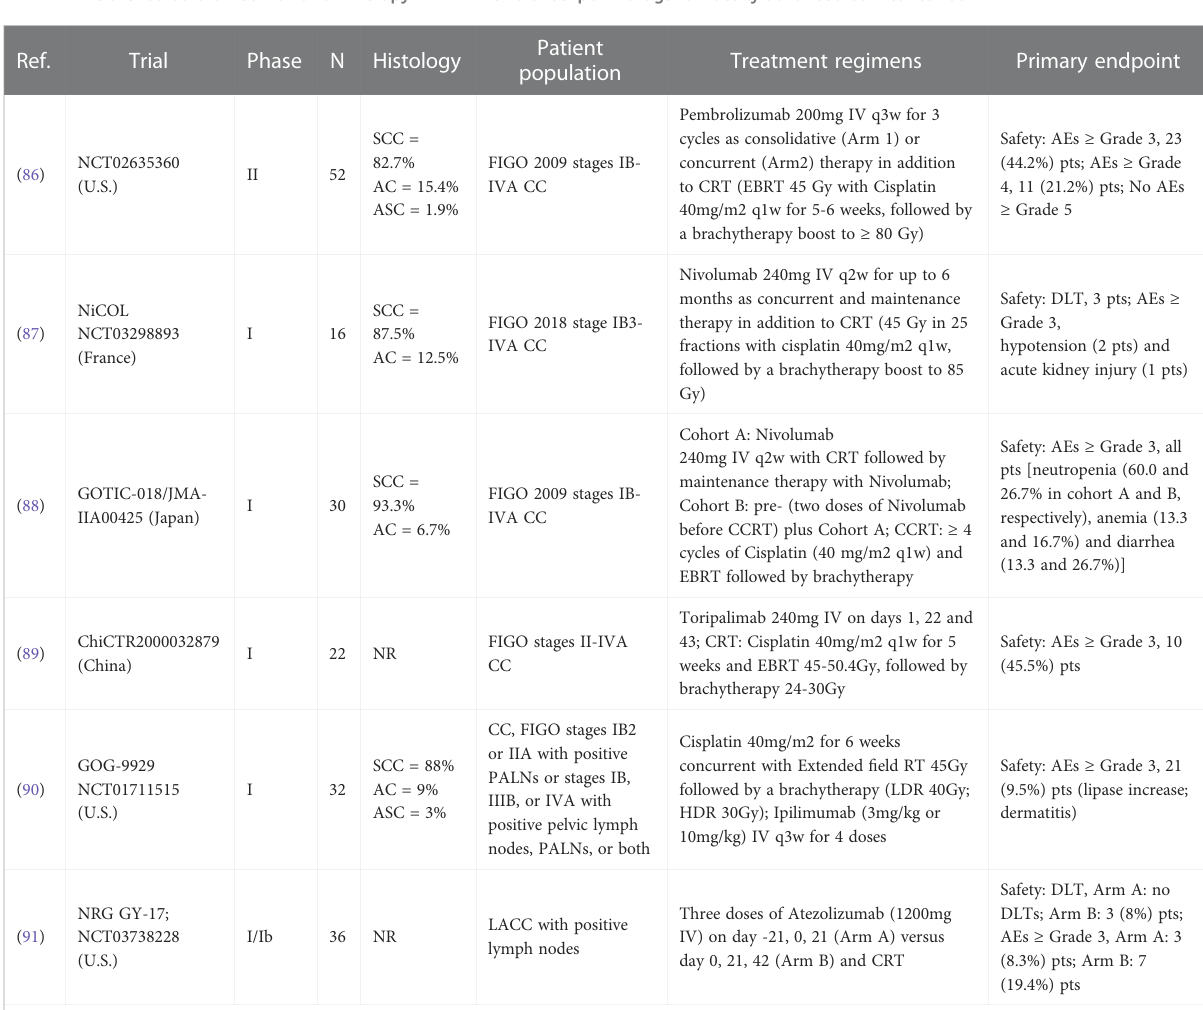
TABLE 4 Published data on combination therapy with immune checkpoint drugs for locally advanced cervical cancer.